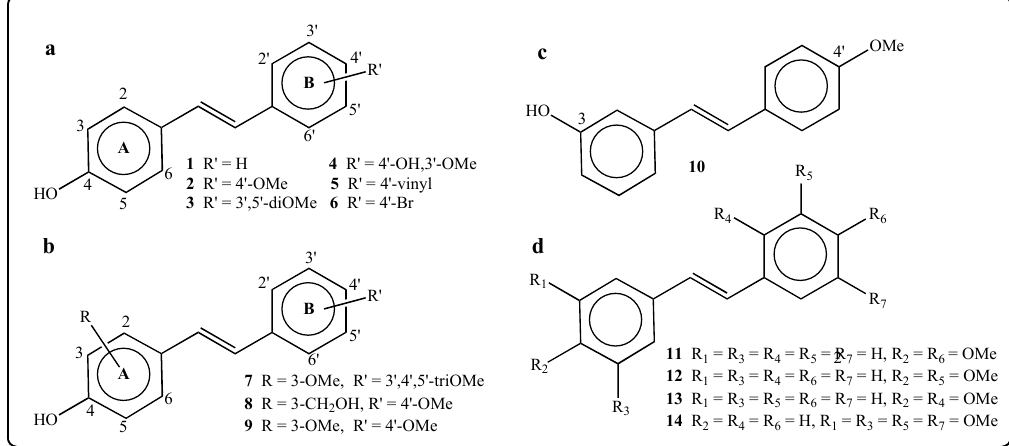
Figure 2. Molecular structure of synthetic stilbene derivatives. ( a ) 4-OH stilbenes bearing substituents on cycle B. ( b ) 4-OH stilbenes bearing substituents on cycle A and/or cycle B. ( c ) 3-hydroxy-4'-methoxystilbene ( 10 ). ( d ) Stilbenes without free phenolic function.